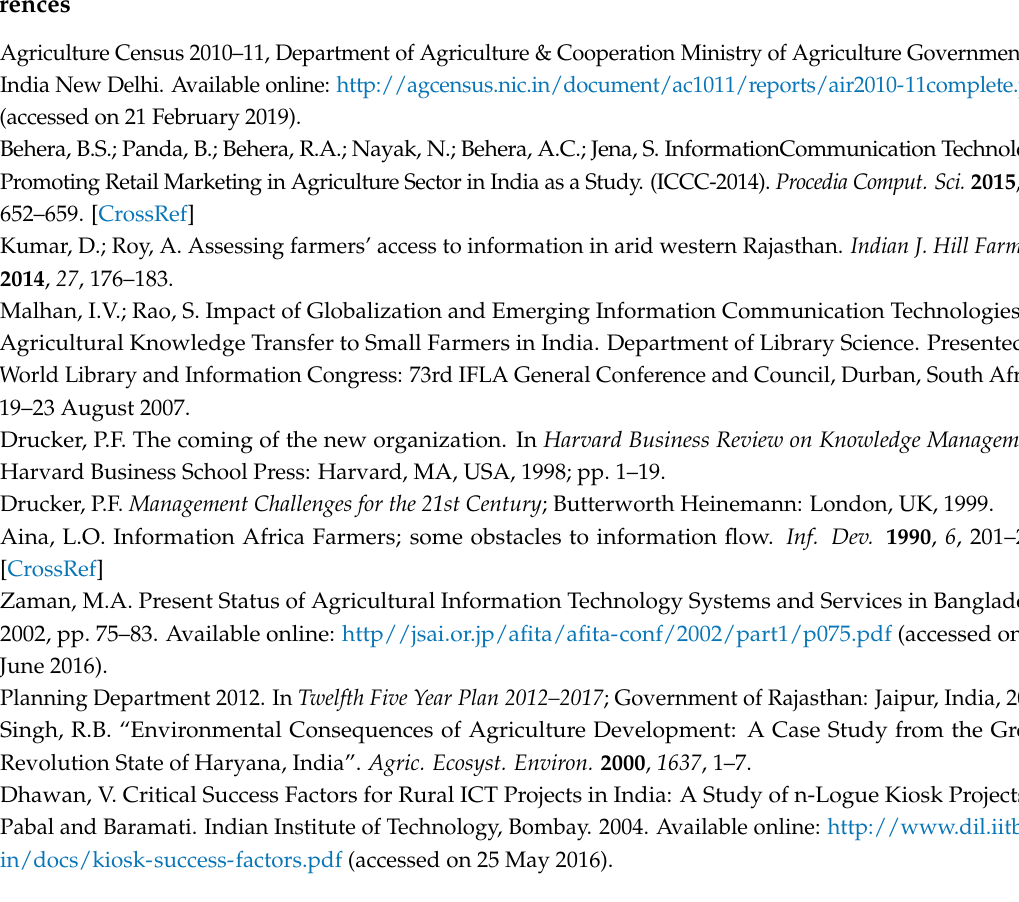
Figure A2. Estimated marginal means of level of access of marketing information (mean) vs. type of users.